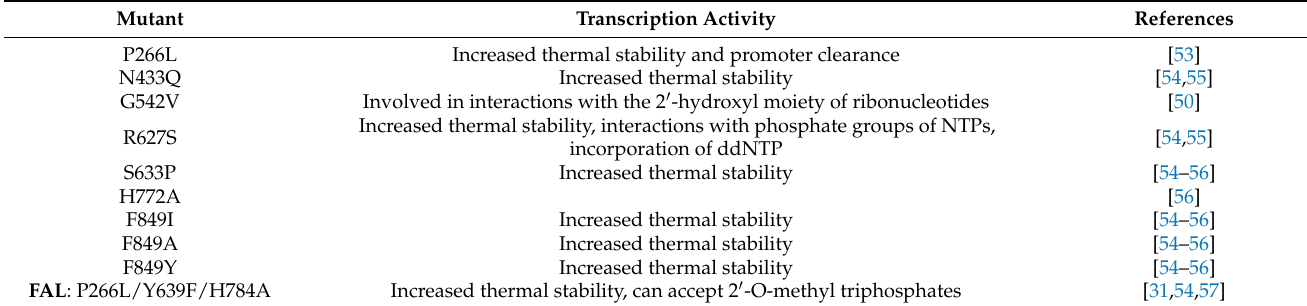
Table 1. Mutants of T7 RNAP, tested in the study.